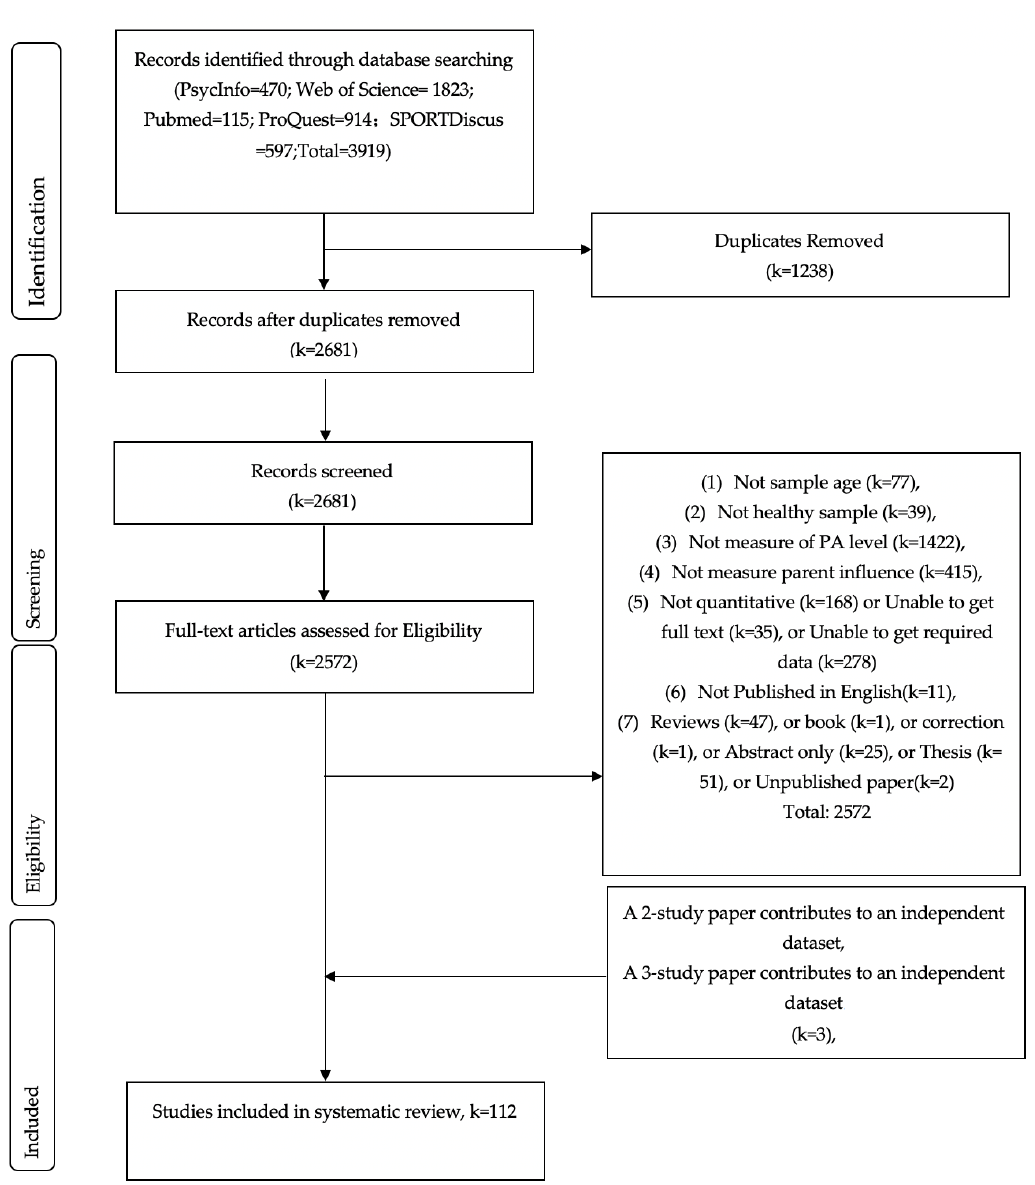
Figure 1. Preferred Reporting Items for Systematic Reviews and Meta-Analyses (PRISMA) flowchart used to identify studies for detailed analysis of parental influence and PA